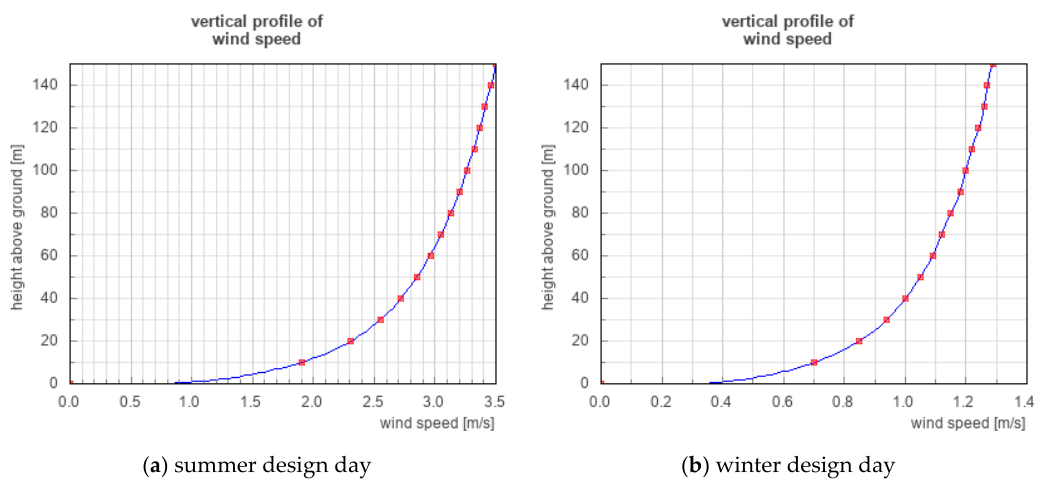
Figure 8. Logarithmic wind profile settings for the CFD simulations of a: ( a ) summer design day, and ( b ) winter design day.